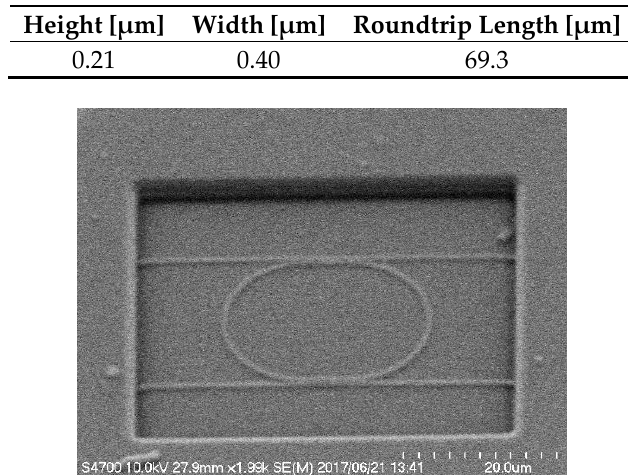
Figure 1. The SEM image of the MRR of the chip.